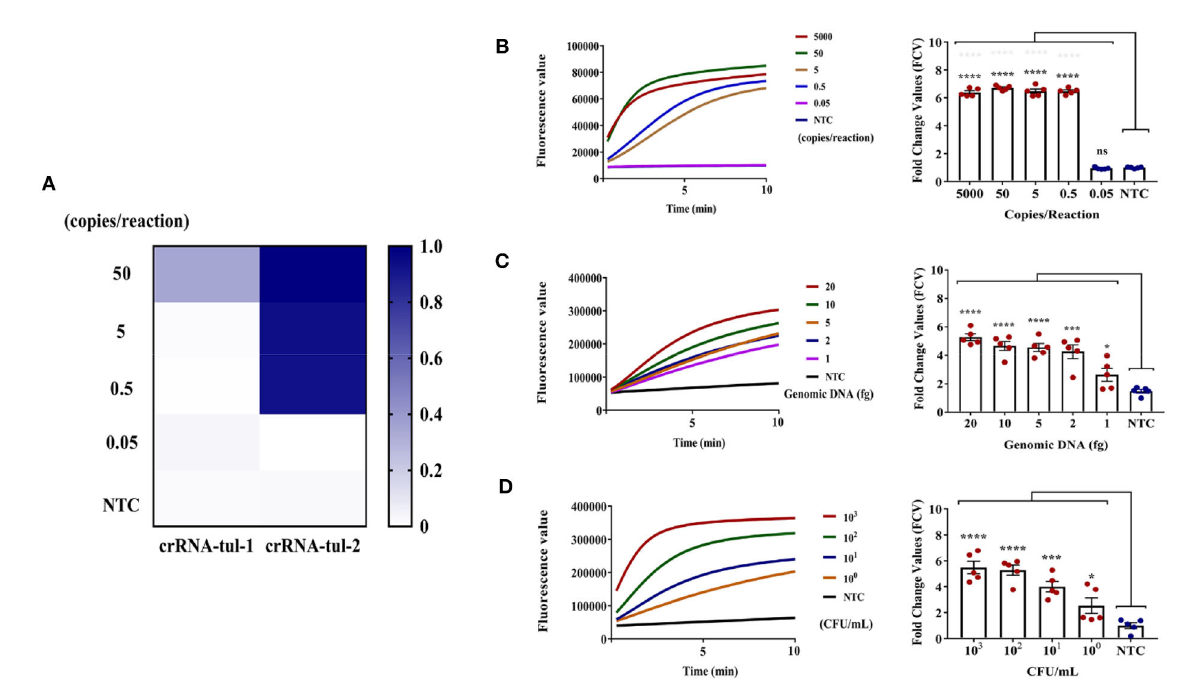
FIGURE3 RPA-CRISPR/Cas12a assay for F. tularensis . (A) Screening optima crRNA of RPA-CRISPR/Cas12a systems under the same DNA template gradient concentration. (B) Sensitivity evaluation by pEASY-T1-TUL4 plasmid, which can reach 0.5 copies/reaction, **** ( P < 0.0001), ns (non-significant). (C) Sensitivity evaluation using genomic DNA of F. tularensis , which can reach 1 fg, **** ( P < 0.0001), *** ( P = 0.0005), * ( P = 0.0385), ns (non-significant). (D) Sensitivity evaluation using F. tularensis , which can reach 2 x 10 0 CFU/ml, **** ( P < 0.0001), *** ( P = 0.0002), * ( P = 0.0427). n = 5 technical replicates; unpaired 2-tailed t -test was used to analyze the difference from the NTC. The fluorescent value–time curves of RT-RPA assay presented are from one representative experiment (the right graph of B–D